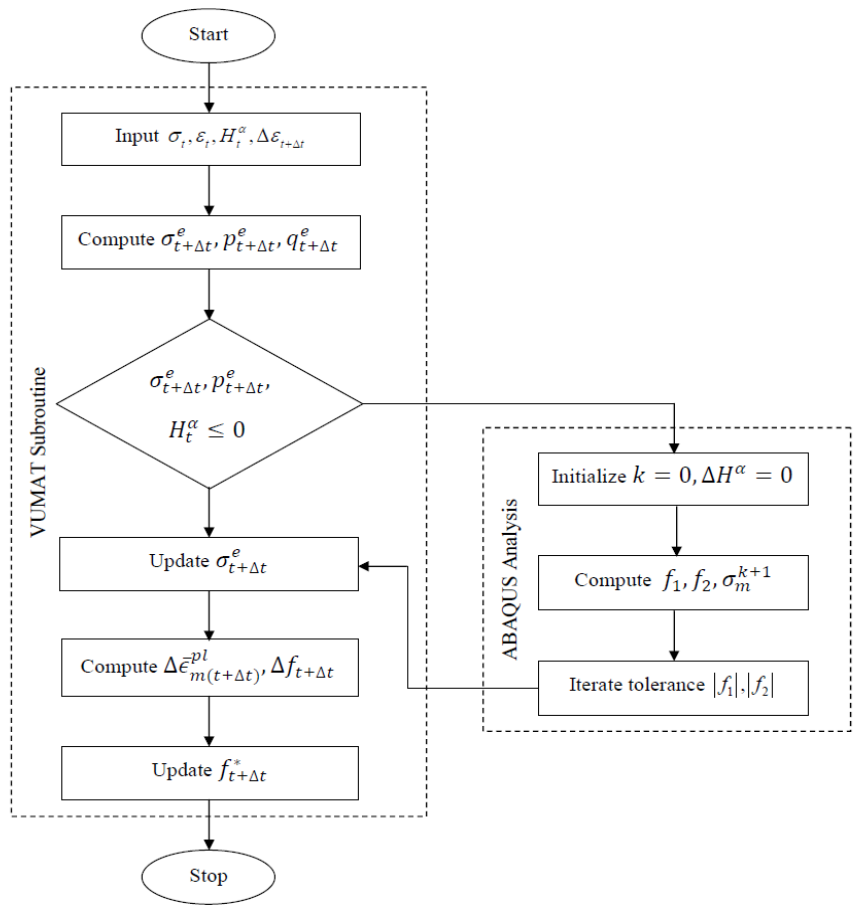
Figure 4. Constitutive modeling of AZ31 alloy using FE approach [22].